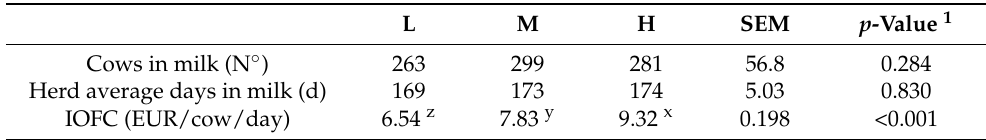
Table 3. Size, average days in milk and income over feed cost (IOFC) of the farms belonging to the low (L), medium (M) and high (H) production classes. L M H SEM